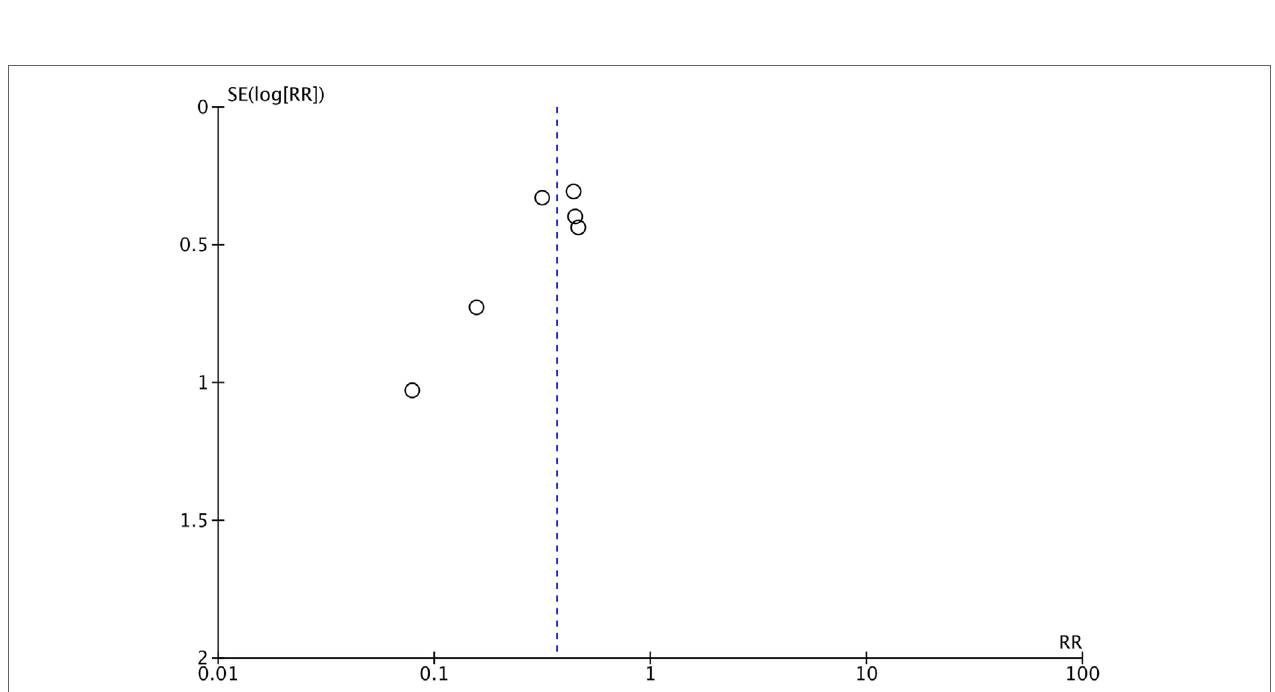
FigURe 3 | Effect of prophylactic cranial irradiation (PCI) on the incidence of brain metastases in 1,287 patients with non-small-cell lung cancer from six trials. Abbreviations: RR: relative risk; CI: confidence